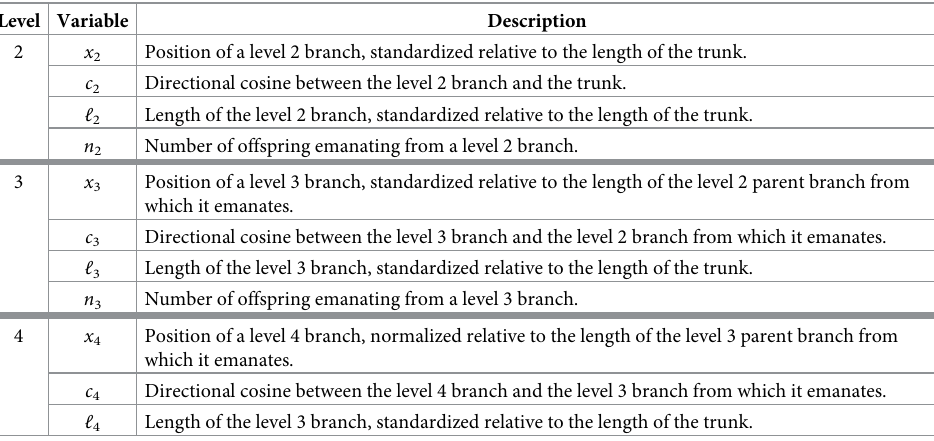
the evaluation points in the interval (0, 1). The origin of the level 3 branch in Table 1 corre-